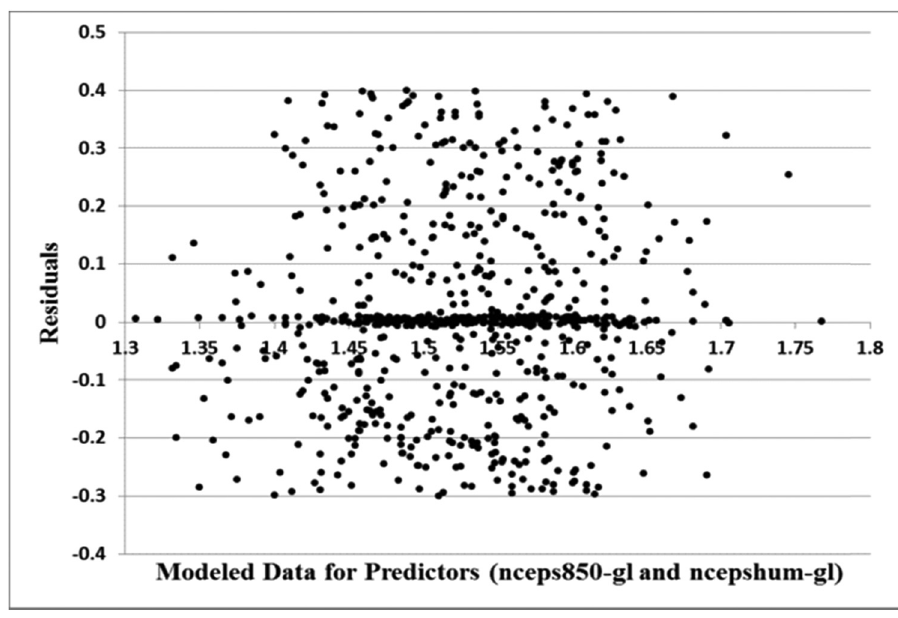
Figure 6: Residuals of predictors for Al - Najaf precipitation modeled data over the period from 2010 to 2020.